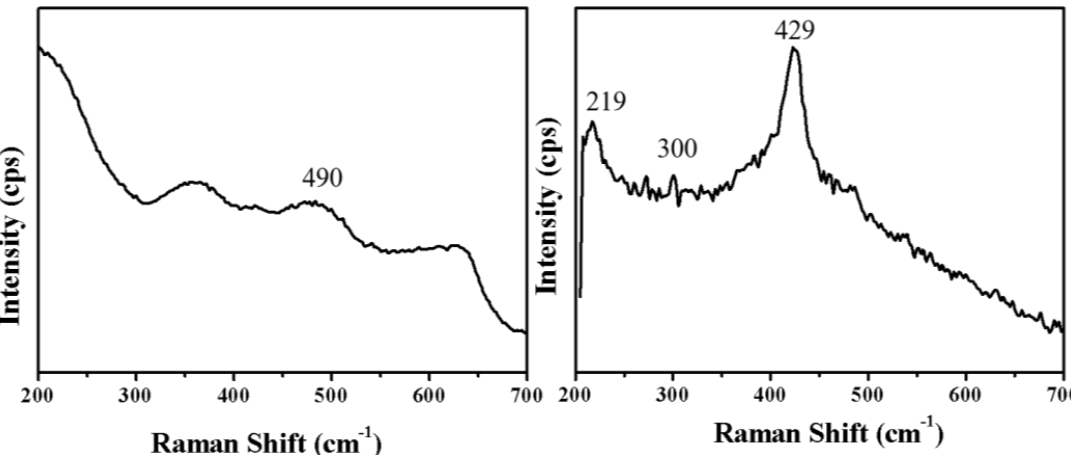
Figure 7. Raman spectra for the HSANs synthesized through 60 min UV-irradiation. Concentration of AgNO 3 precursor: 5 M.